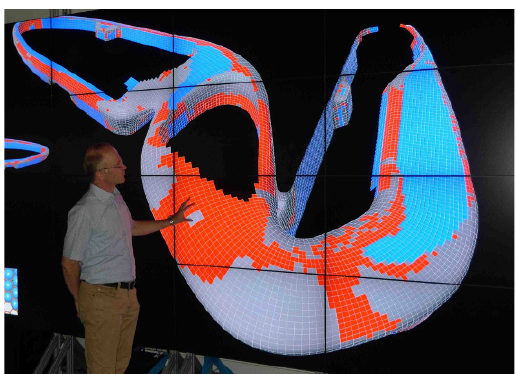
Figure 26. KAUST’s AESOP showing content by Helmut Pottman. Photo: Tom DeFanti.